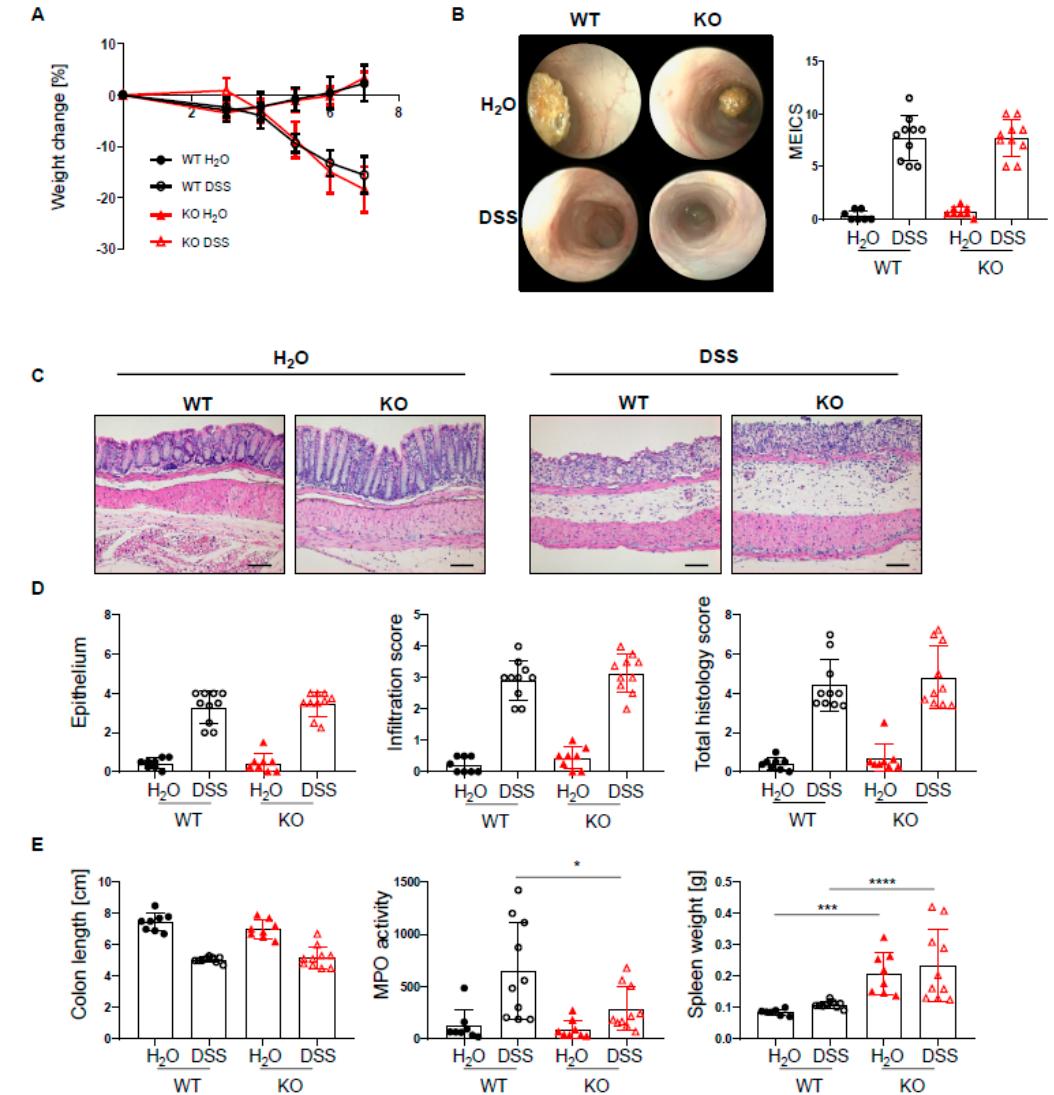
Figure 2. PTPN2 deficiency in DCs does not aggravate inflammation in acute DSS colitis. PTPN2 fl/fl (WT) and PTPN2 fl/fl xCD11c Cre (KO) mice received 2.5% DSS for 7 days: ( A ) relative weight changes; ( B ) representative pictures from colonoscopy and murine endoscopic index of colitis severity (MEICS); ( C , D ) representative pictures from H&E staining of the terminal colon and histological scoring; ( E ) colon length, MPO activity, and spleen weight. Scale bars represent a length of 100 mm. * p < 0.05, *** p < 0.001, **** p < 0.0001; unpaired Mann–Whitney test. Data are representative for one out of two independent experiments with 4–5 mice per experimental